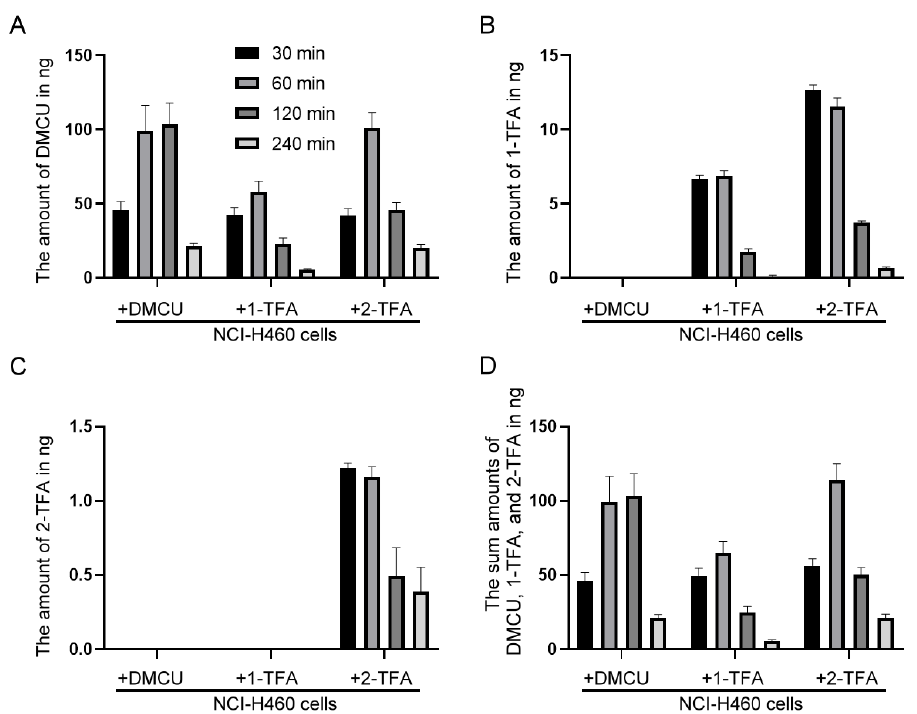
Figure 4. The intracellular levels of DMCU , 1-TFA and 2-TFA in the NCI-H460 cells. The cellular extracts were obtained from DMCU , 1-TFA , or 2-TFA treated cells at the indicated time intervals. The amount of drug uptake , ( A ) DMCU , ( B ) 1-TFA , ( C ) 2-TFA , or ( D ) sum amounts of DMCU , 1-TFA , and 2-TFA, was evaluated in the cellular extracts of approximately 1 × 10 6 cells by LC-MS analysis. Data are presented as mean and SD from three experiments.